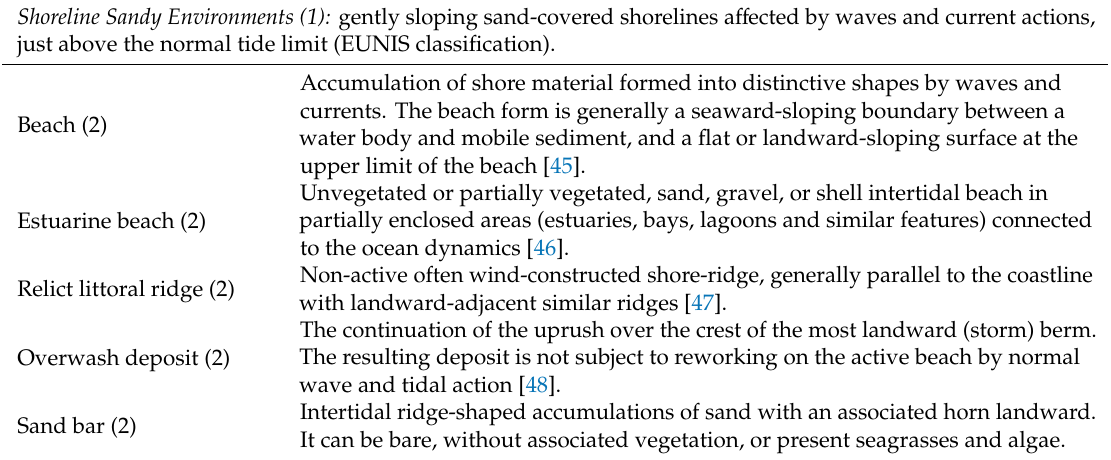
Table 1. Hierarchical classification applied to the study sites with types of features and brief definitions. Numbers between brackets after the name of the unit indicate the level of the category (Category 1: subsystem, Category 2: features, Category 3: more specific